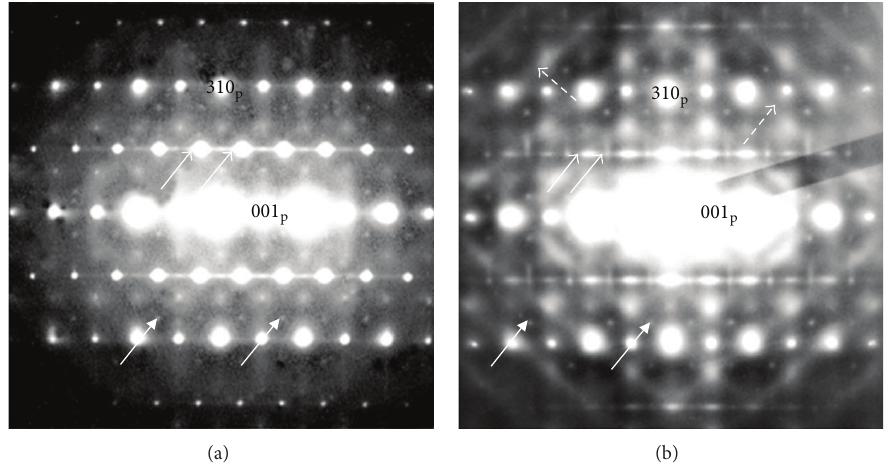
Figure 3: Electron diffraction patterns along a 301